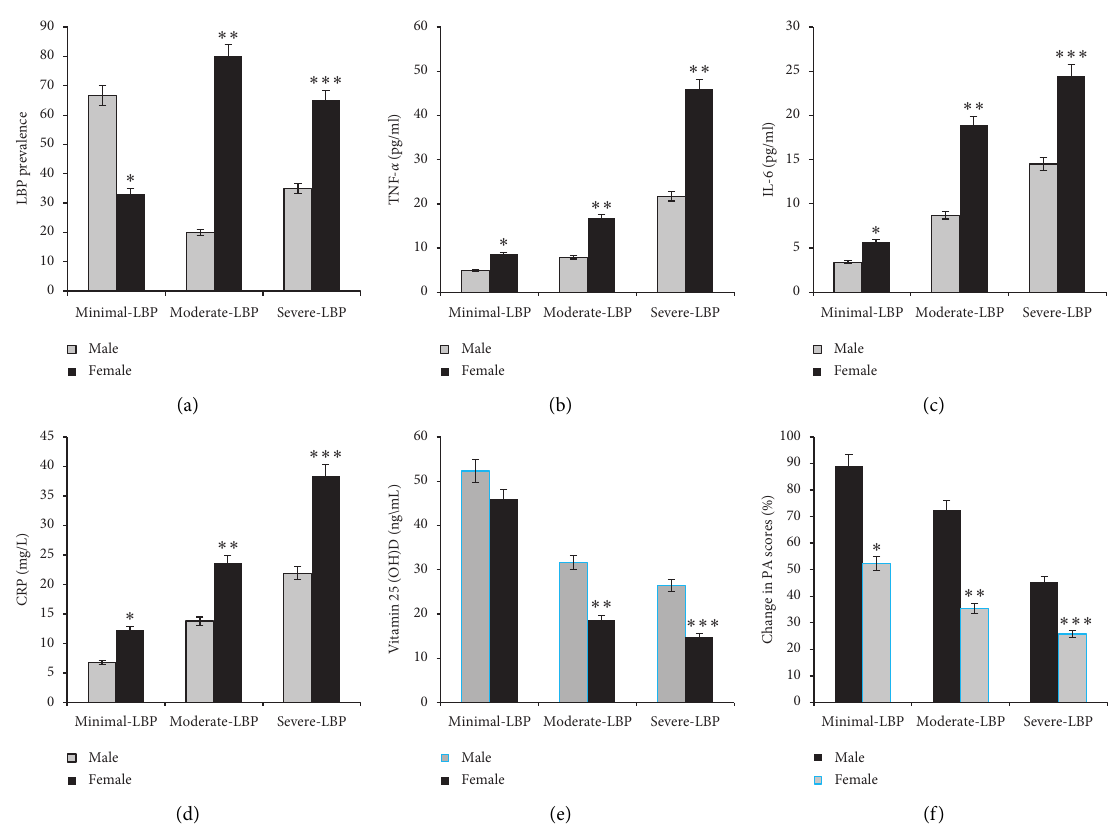
Figure 2: Effect of gender on LBP prevalence rates, serum levels of inflammatory markers as TNF- α , IL-6, and CRP, vitamin D serum levels, and physical activity scores in older adults ( n � 110). Regarding LBP prevalence, a higher incidence of LBP was reported in females compared to males (a). In addition, a significant increase in the levels of TNF- α , IL-6, and CRP and a decrease in the levels of vitamin D and PA scores were found in females with minimal ( p � 0 . 05), moderate ( p � 0 . 01), and severe ( p � 0 . 001) LBP compared to males of the same group